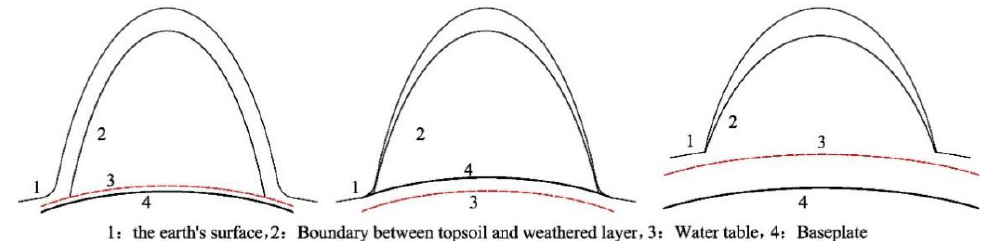
Figure 11. Relationship between ore body floor and groundwater level.